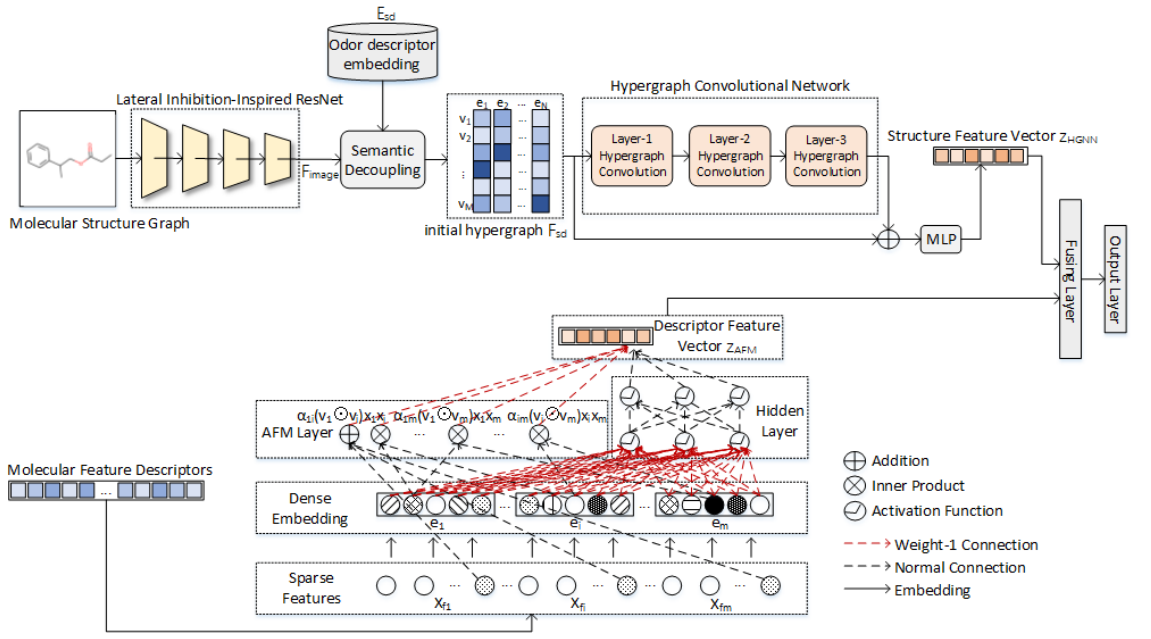
Figure 1. The overall architecture of the proposed olfactory perception model